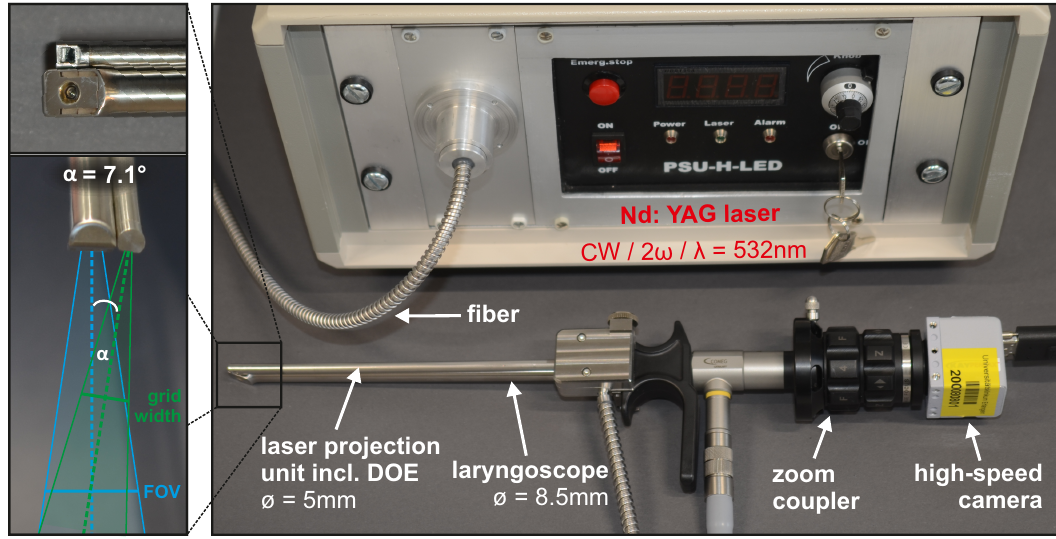
Figure 2. Overview of the experimental measuring device. The imaging unit comprises a rigid 70 ◦ -laryngoscope, a zoom coupler and a high-speed camera. A frequency-doubled Nd:YAG laser source is connected to the laser projection unit via a glass fiber. Different perspectives on the tip of the miniaturized endoscopic laser projection unit are provided on the